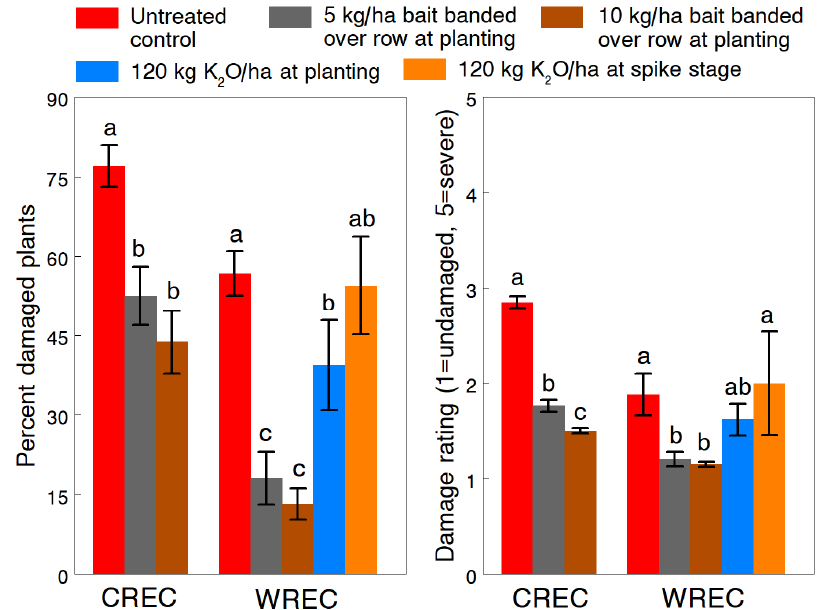
Figure 5. Effects of banded applications of pelleted 4% metaldehyde bait (Deadline Bullet, AMVAC Chemical Corp., Los Angeles, CA, USA) and broadcast dry granular applications of potash on the percentage and severity of plant damage of the gray garden slug, Deroceras reticulatum . Means ( ± SEM) are presented for studies conducted at two University of Maryland research farms in 1994. Pairs of means within each study with different letters are significantly different at the 5% probability level.